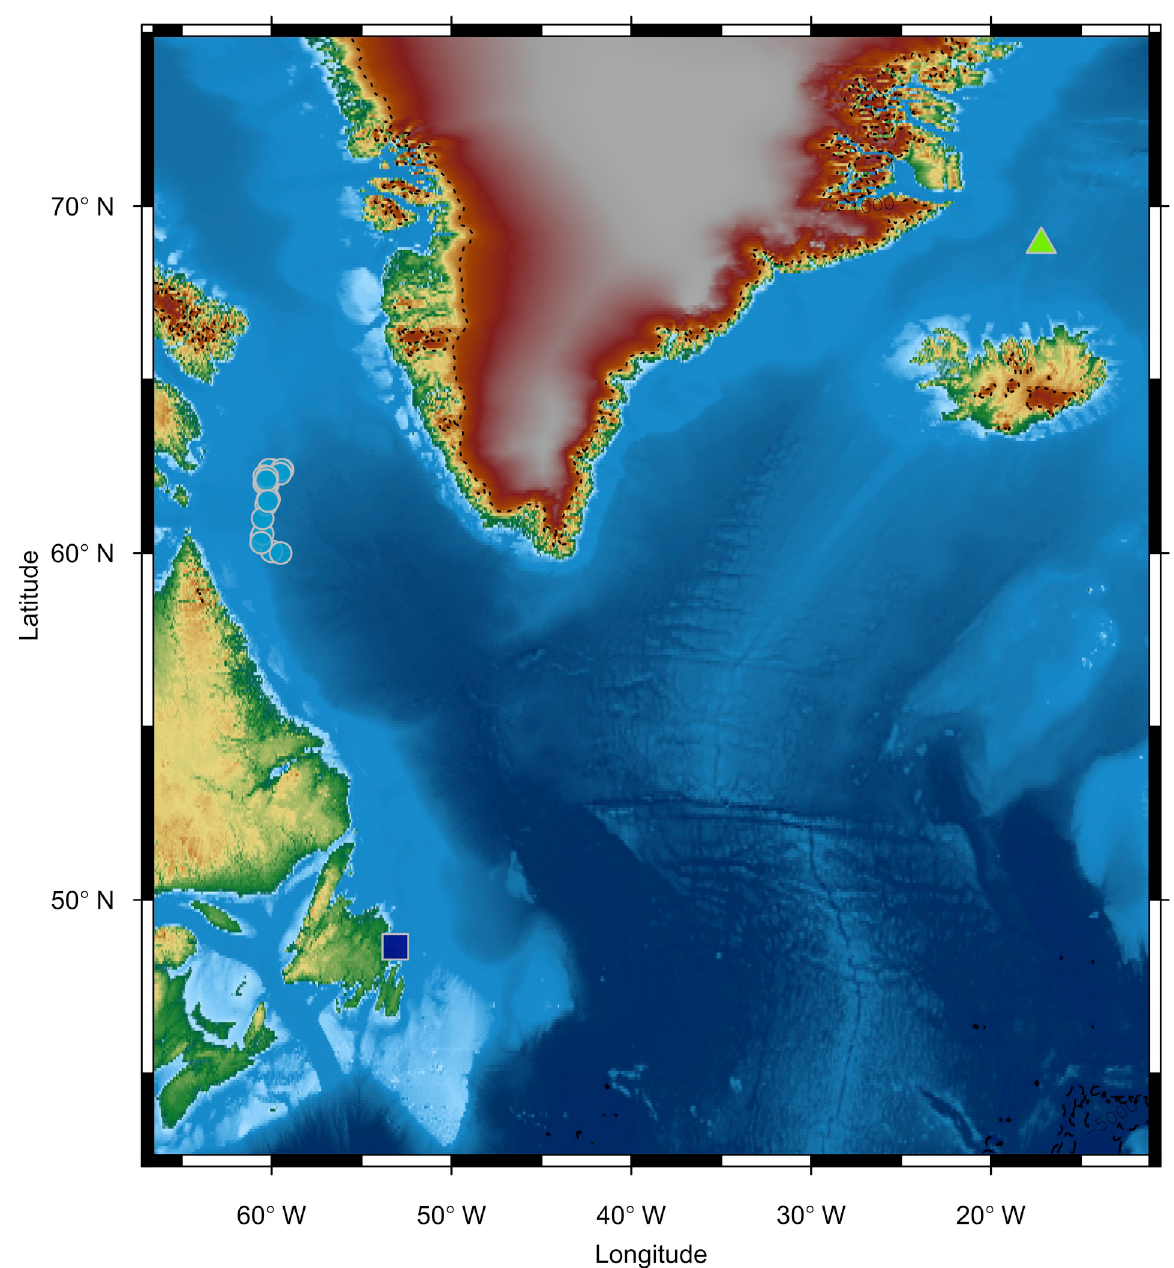
Fig 1. Map of study area regions and specimen collection locations. Green triangle = Iceland, light blue dots = Northern Labrador, dark blue square = Newfoundland strandings.